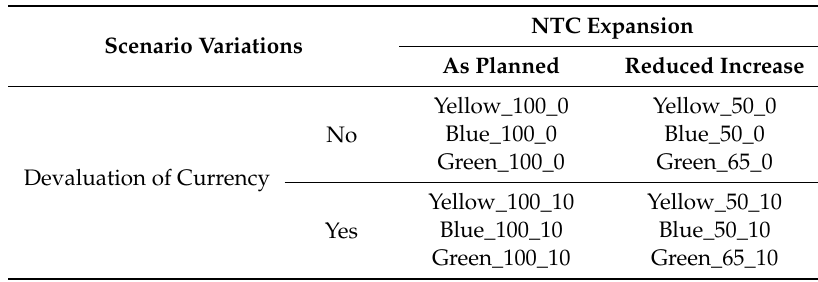
Table 1. Scenario variations. Source: Own compilation.